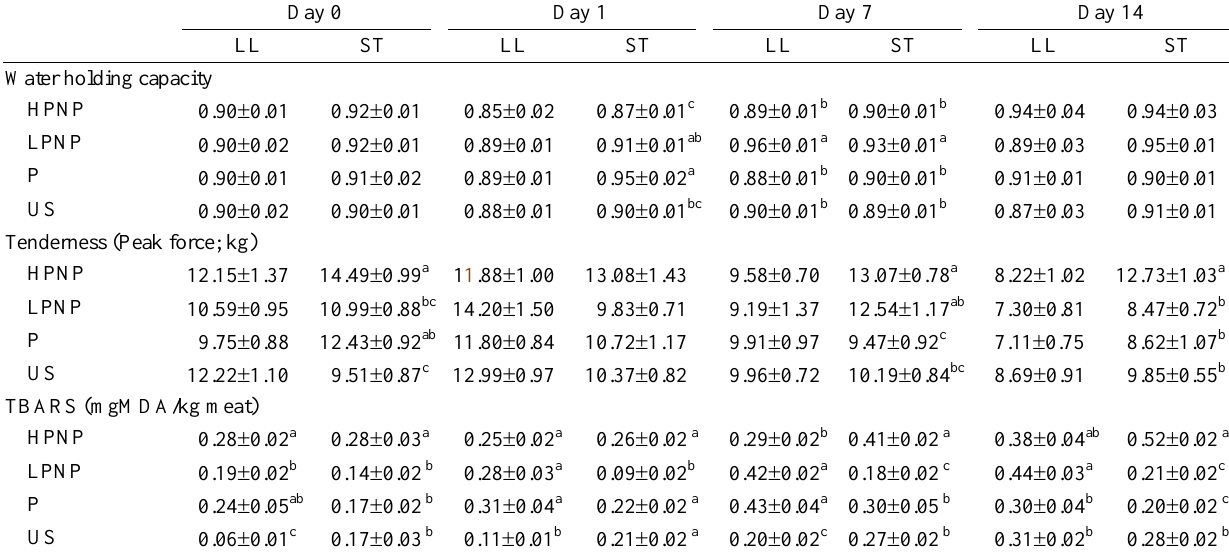
Table 1. Effects of stunning on water holding capacity, TBARS and tenderness at different day(s) of ageing (Mean 